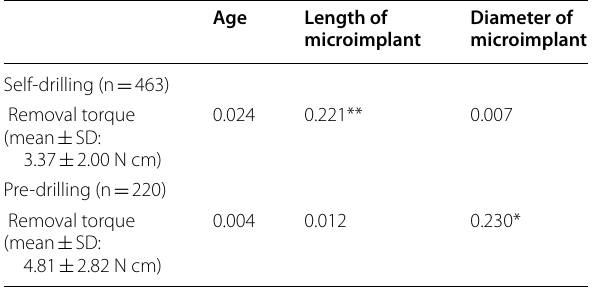
Table 6 Correlation coefficients of removal torque, age, and length and diameter of microimplants